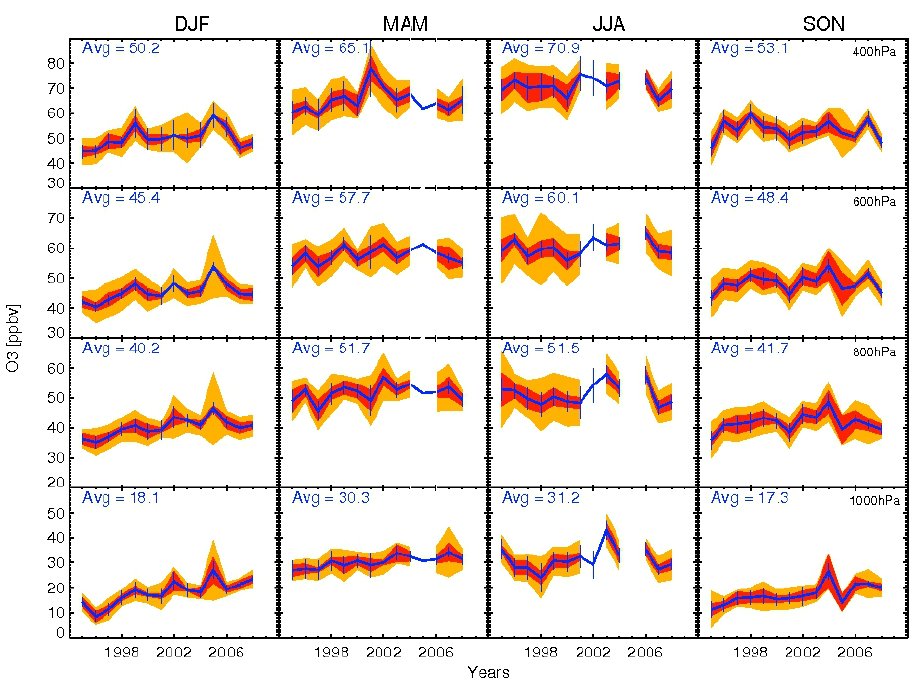
Fig. 4. Time evolution of the ozone seasonal means over Frankfurt between 1995 and 2008 as observed by MOZAIC aircraft at four pressure levels (1000, 800, 600, 400hPa, from bottom to top). The seasonal mean ( x seas , yr ) from the morning data set is shown in blue with the 95% confidence limit error bars (CI 95% = t 0 . 05 · se seas , yr ). The shaded areas represent the sampling uncertainty (range [ x seas , yr − 2 . 6 · s samp , N f seas , yr , x seas , yr + 2 . 6 · s samp , N f seas , yr ], see Sect. 3.5.2 for details) derived from the ensemble of subsamples of 4 (orange) and 12 (red) profiles a month for each year and season. At the top left corner of each rectangle, the average seasonal means over the entire period are